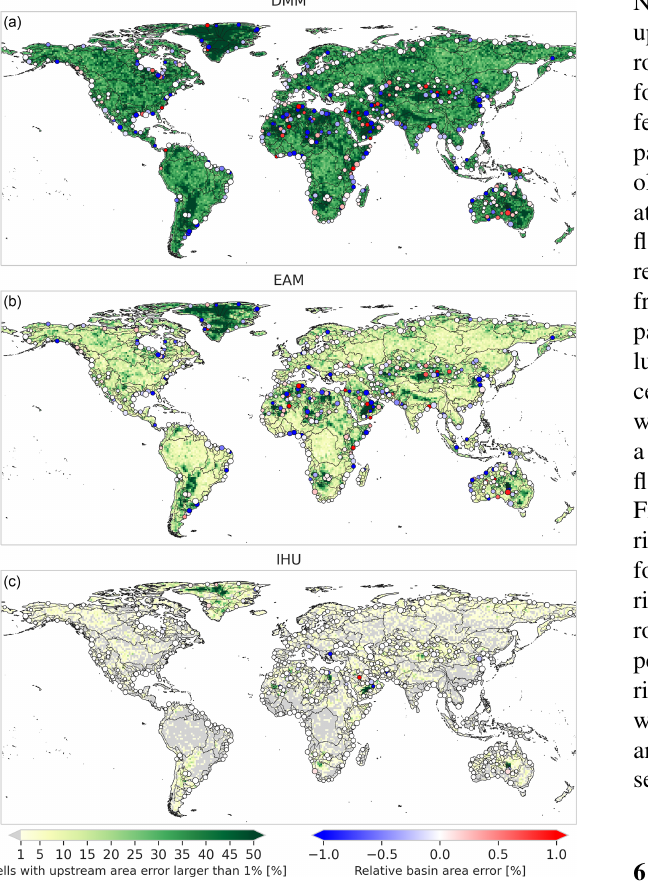
Figure 5. Relative upstream area error ((cid:15) rel at a 5arcmin resolu- tion ( ∼ 10km)) for the DMM (a) , the EAM (b) and IHU (c) . The background colors show the percentage of cells per 1 × 1 ◦ tile with a relative upstream area error of more than 1%, while the markers show the relative upstream area error at the outlets or sinks of the 500 largest basins globally (black